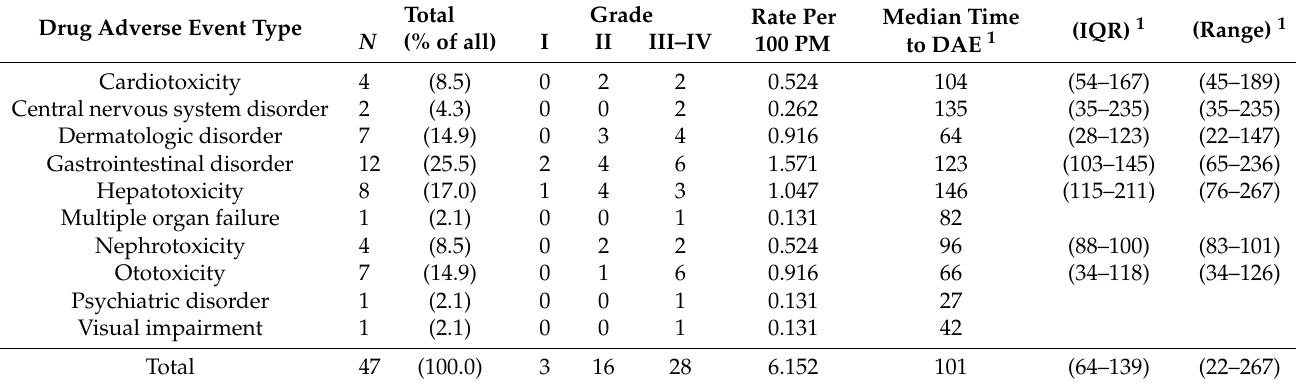
Table 2. Frequency, severity, time of onset of drug adverse events among 95 RR-TB patients enrolled in shorter treatment regimen. Drug Adverse Event Type